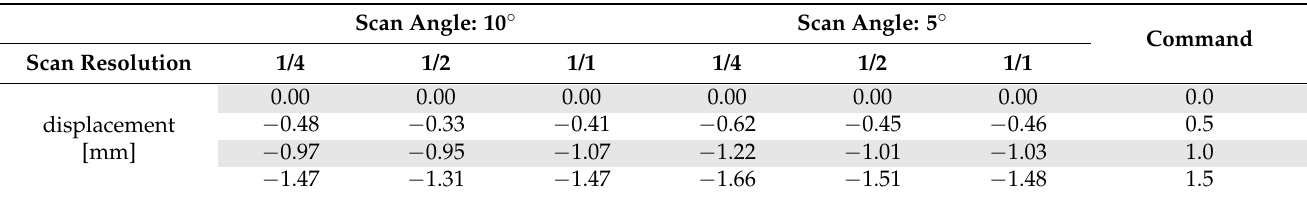
Table 3. Displacements from a distance of 10 m measured with the laser scanner.